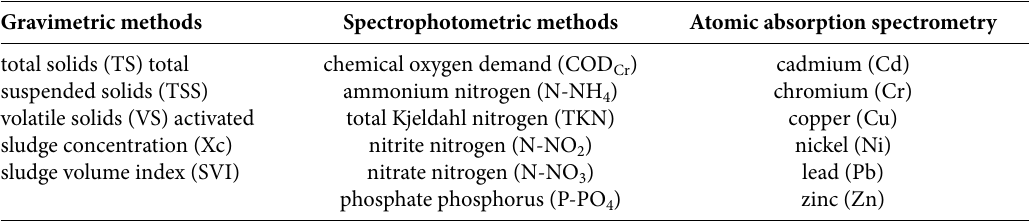
Table 1. Analysed parameters, their abbreviations (symbols), and the method of determination. Gravimetric